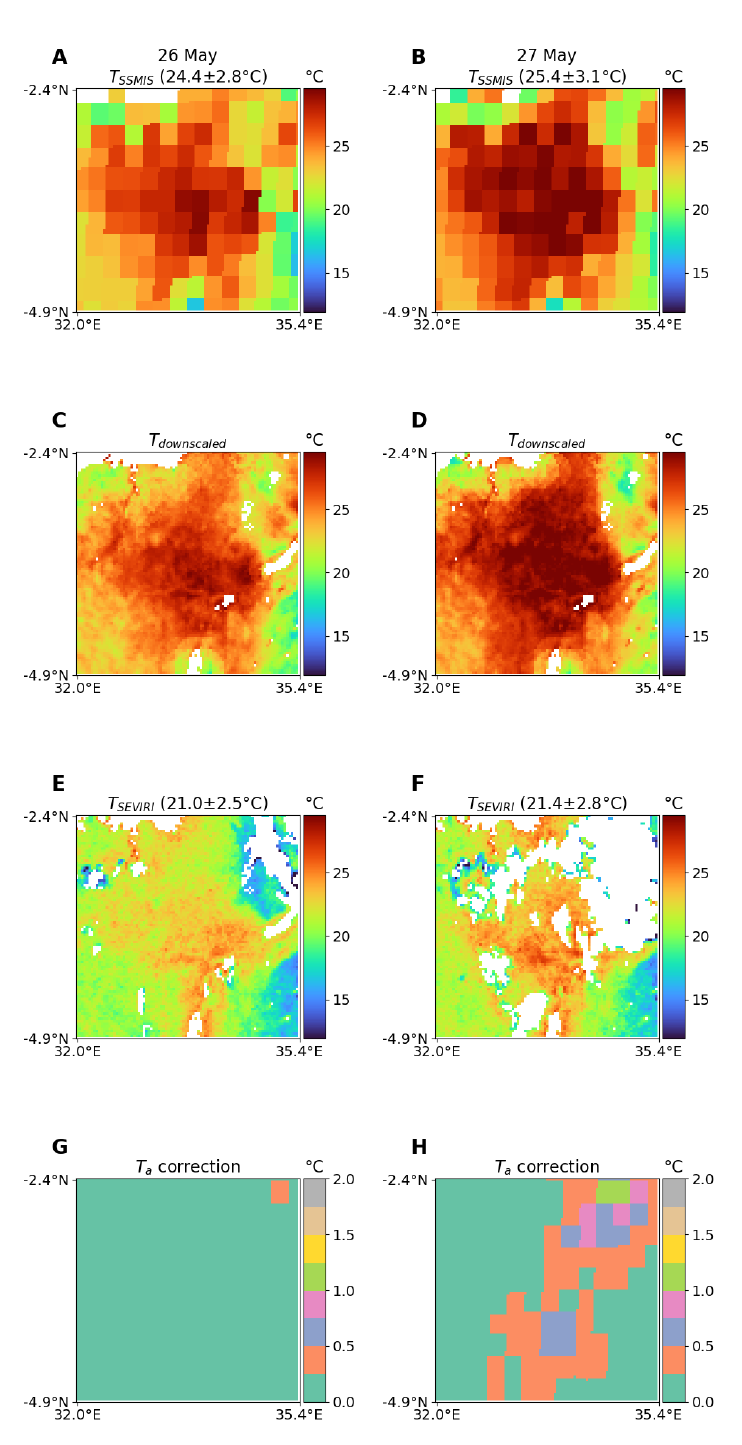
Figure 11. Scenes from the afternoon overpass during 2 consecutive days, 26 and 27th of May 2016 over northern Tanzania (2.4 ◦ S 32 ◦ E to 4.9 ◦ S 35.4 ◦ E) : On the first line ( A , B ) is the SSMIS observation at low resolution, then panels ( C , D ) show the result after the downscaling scheme is applied, ( E , F ) show the T SEVIRI at the same time. Finally, the last row ( G , H ) shows the correction on the T a parameter derived from the ERA5 reanalysis. The average and standard deviation of T SSMIS and T SEVIRI for the clear-sky parts of the scene are indicated in the sub-panel